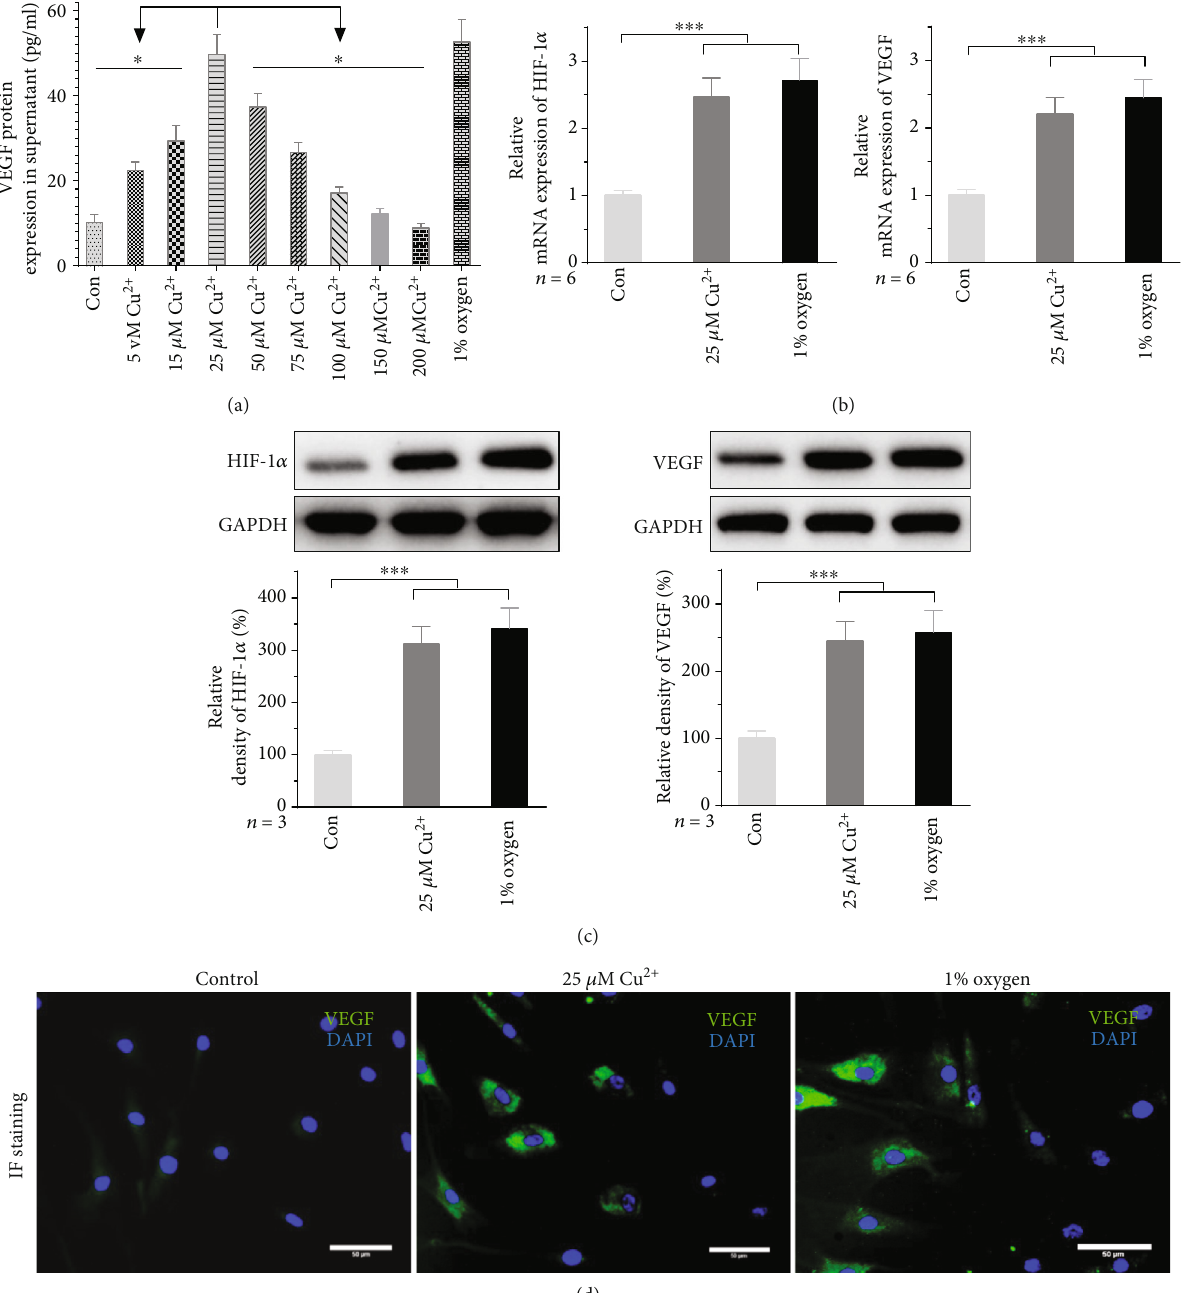
Figure 5: 25 μ M copper is an appropriate concentration to activate the HIF-1 α signaling pathway. (a) ELISA detected VEGF secretion on the di ff erent copper ions and 1% hypoxia niche stimulation. ∗ means P < 0 : 05 . (b, c) The expression of the HIF-1 α signaling pathway-related gene (HIF-1 α , VEGF) was measured by RT-qPCR and western blot in the BMSCs under the 25 μ M Cu 2+ stimulation and 1% hypoxia intervention for 7 days. The results are depicted as the mean ± SEM . ∗ P < 0 : 05 , ∗∗ P < 0 : 01 , and ∗∗∗ P < : 001 . (d) The IF staining of VEGF in BMSCs under the di ff erent stimulations for 7